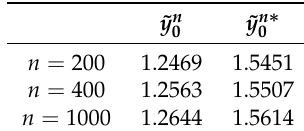
Table 2. The values of the reflected solution ˜ y n